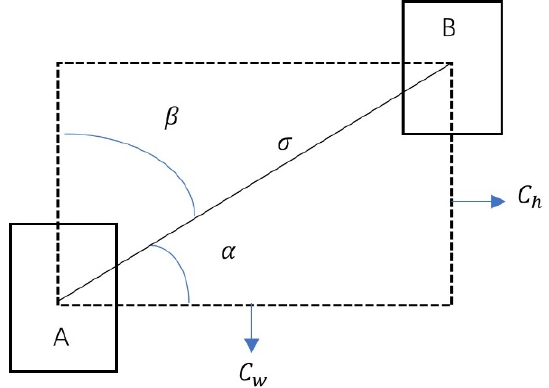
Figure 4. Angle cost scheme in the loss function.